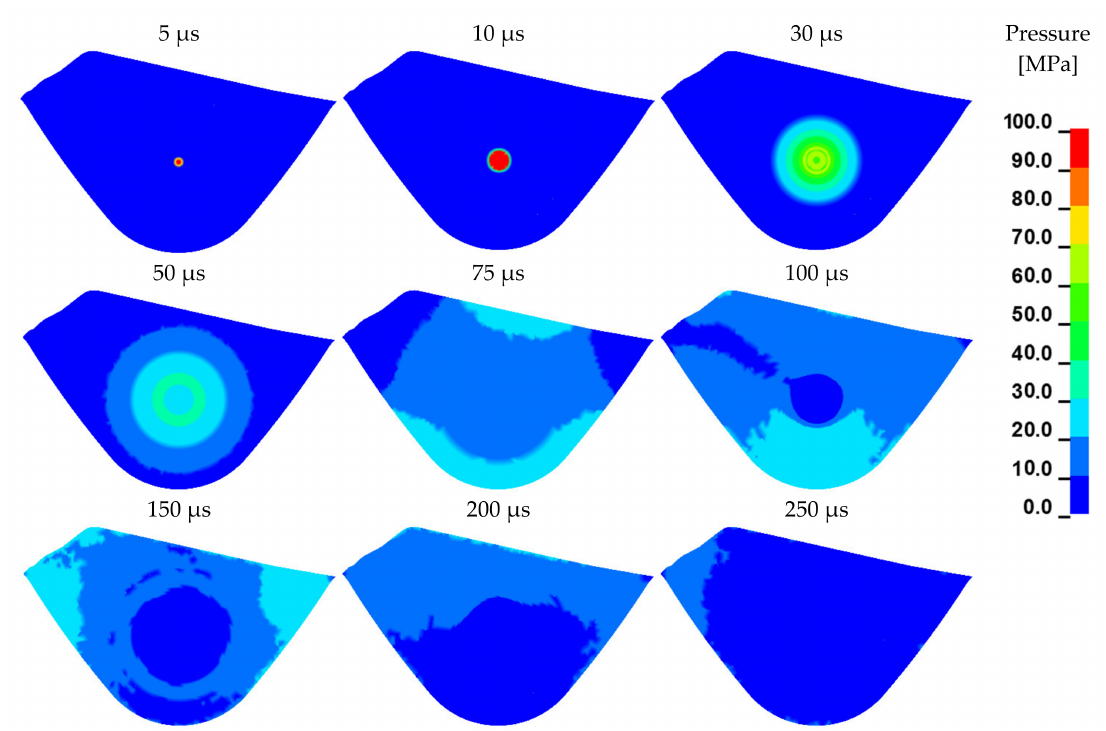
Figure 5. Distribution of pressure in the EHF chamber along the cross-section A-A for the last discharge when the die cavity is completely filled with the